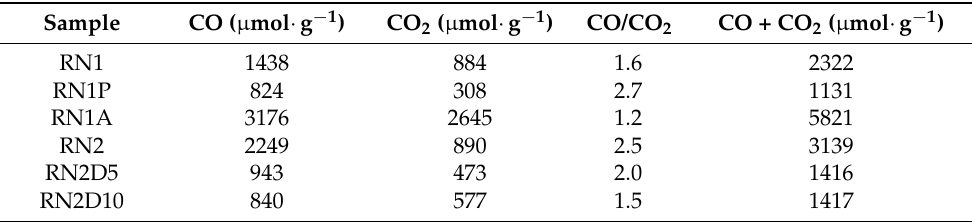
Table 3. Amount of CO and CO 2 evolved during the temperature programmed desorption (TPD)